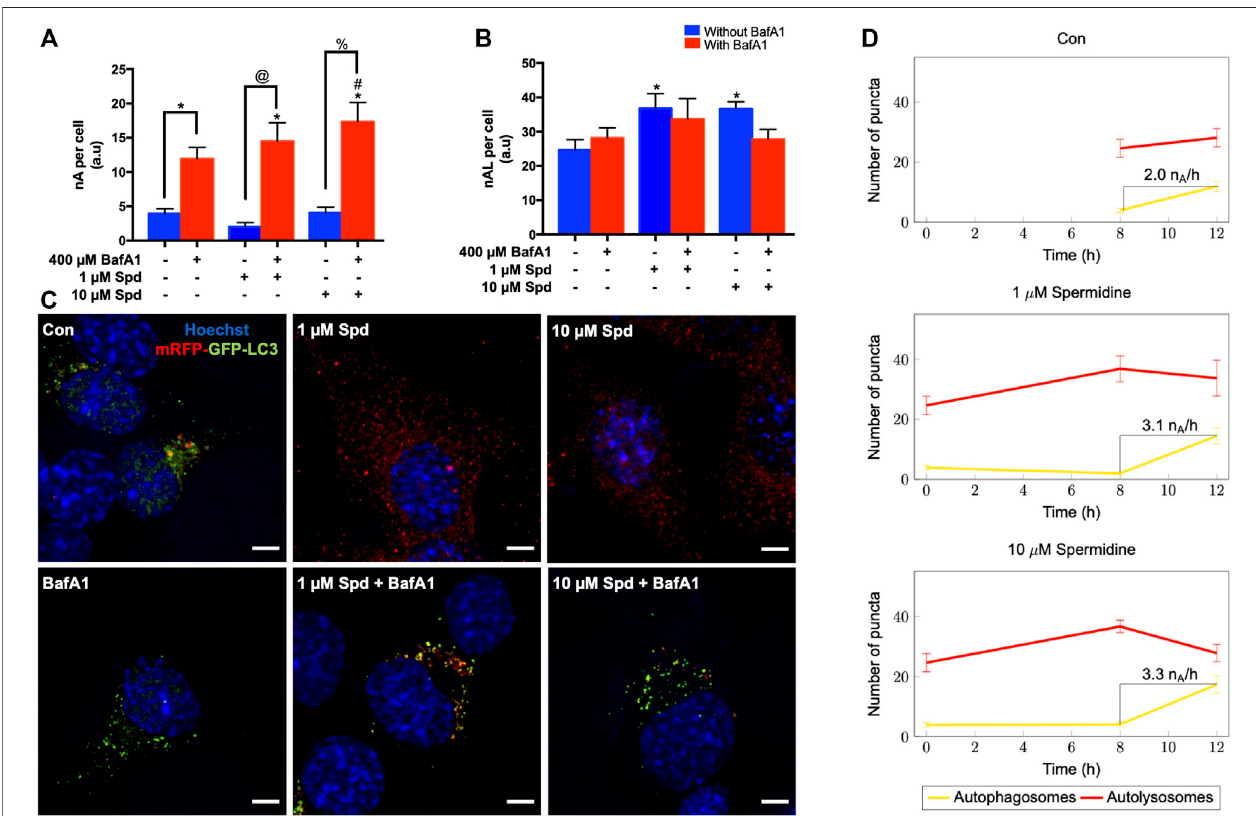
FIGURE 2 | Spermidine induces autophagic fl ux in a concentration-dependent manner. (A,B) quantitative analysis and (C) representative fl uorescence micrographs of autophagosome pool size (A,C) and autolysosome pool size (B,C) in GT1-7 cells following treatment with 1 and 10 μ M spermidine in the presence and absenceofsaturatingconcentrationsba fi lomycin.Dataarepresentedasmean±SEM,n=3,withatotalof30cellsanalysedpertreatmentgroup.*= p < 0.05vscontrol, # = p < 0.05 vs BafA1, @ = p < 0.05 vs 1 μ M Spd and % = p < 0.05 vs 10 μ M Spd, arbitrary units (a.u). Scale bar: 5 μ m. (D) Autophagosome fl ux under basal and induced conditions calculated from the initial slope of autophagosomes accumulation. Autophagosome fl ux increased in a concentration-depended manner, raising from 2.0 autophagosomes/h/cell under basal levels to 3.1 autophagosomes/h/cell and 3.3 autophagosomes/h/cell under induced conditions with 1 and 10 μ M Spd